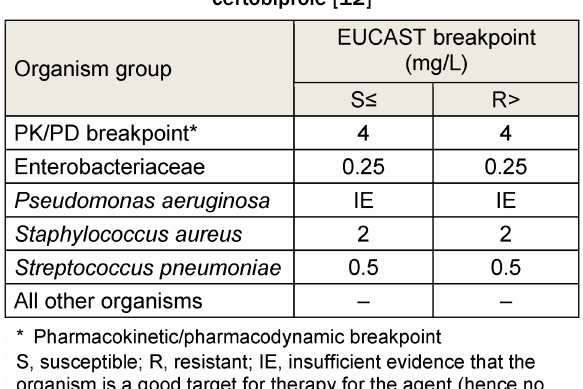
Table 1: Minimum inhibitory concentration breakpoints